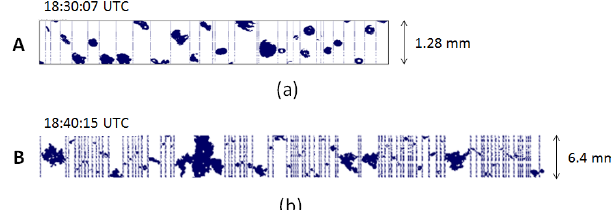
Figure 11. Samples of 2-D imagery from the SPEC 2D-S (a) and DMT PIP (b) probes at two time stamps as in Fig. 10. The width of the 2D-S image strip is 1.28mm and that of the PIP is 6.4mm. The aircraft’s altitude was 6.75km at A and 6.74km at